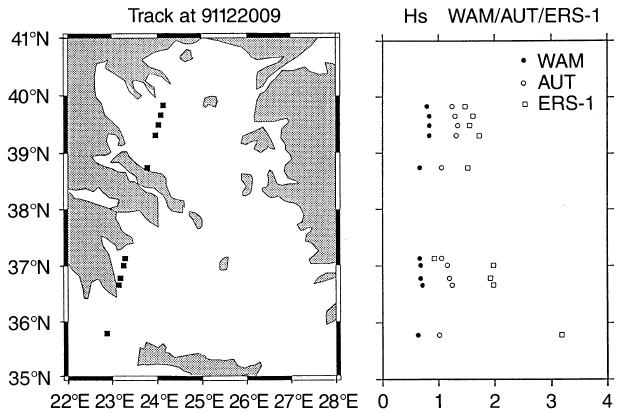
Fig. 16. Comparison of H s values between WAM, AUT models and ERS-1 wave data (track at 91122009)